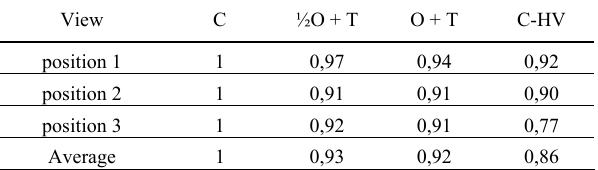
Table 4: Transparency at three views at the example of the structure